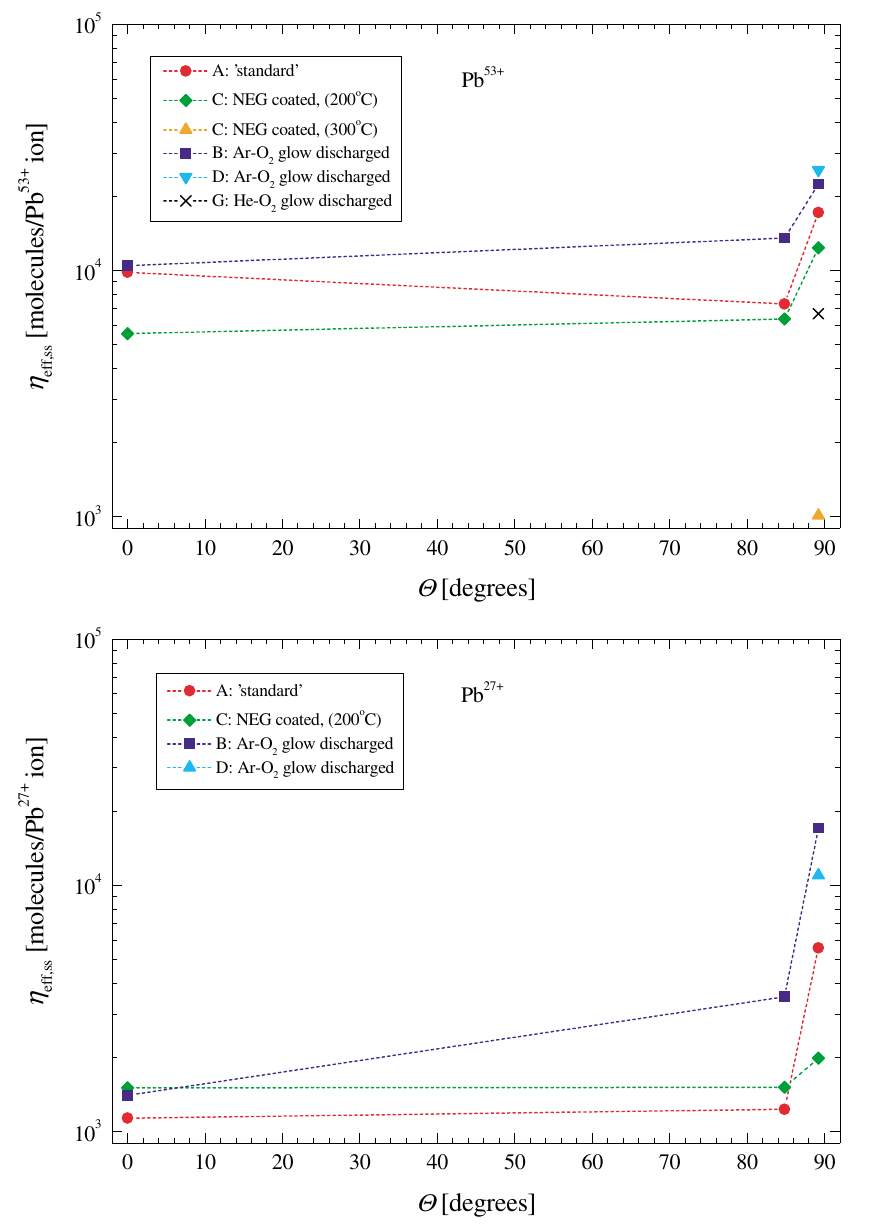
FIG. 9. (Color) Effective desorption yields of lead ions at 4 : 2 MeV = u measured for three different impact angles (cid:6) and two charge states q . Upper curve: Pb 53 (cid:1) , lower curve: Pb 27 (cid:1) . Normal incidence corresponds to (cid:6) (cid:6) 0 (cid:7)